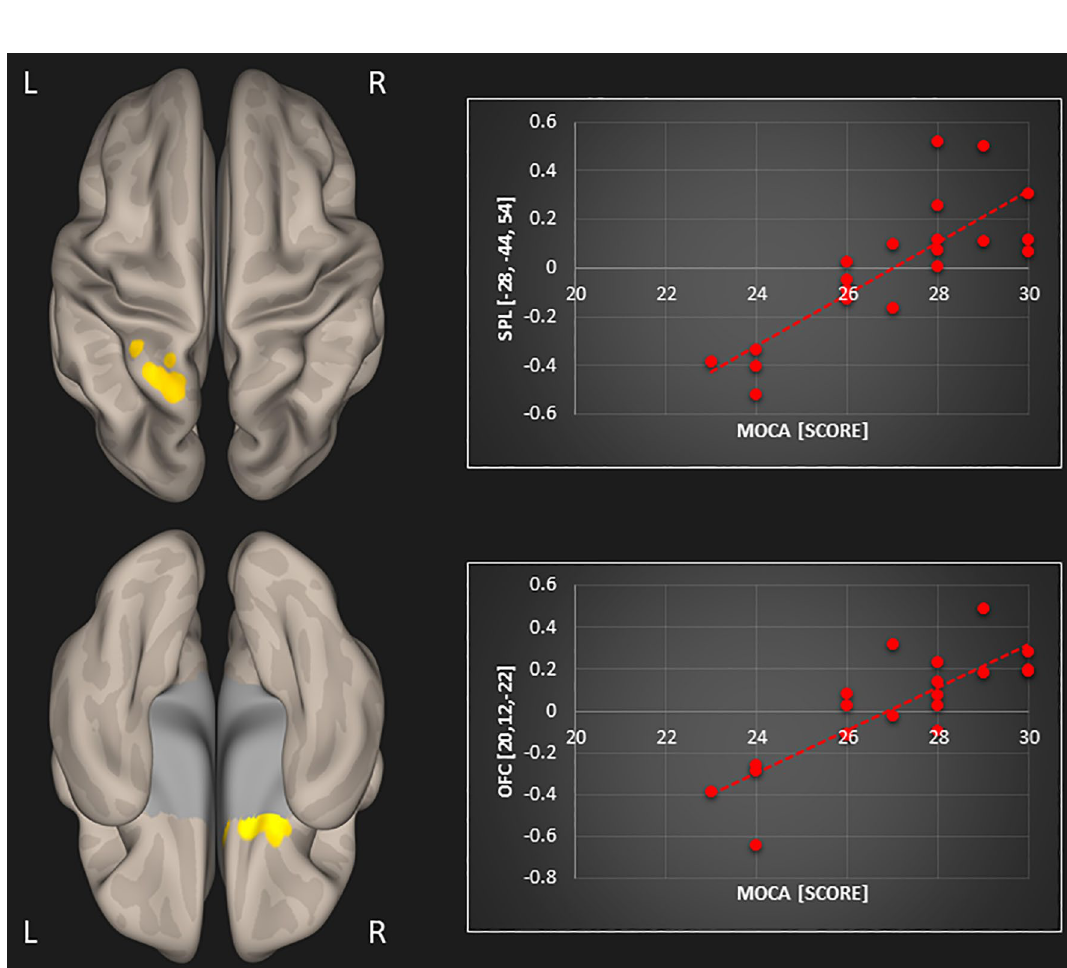
Figure 1. Significant association between MoCA scores and resting-state functional connectivity of the default mode network with the left superior parietal lobule (SPL; top row) and the right orbitofrontal cortex (OFC; bottom row) in tinnitus patients [p < 0.05; FWE cluster-corrected threshold]. Significant brain areas were displayed on an inflated brain by CONN version 20b 31